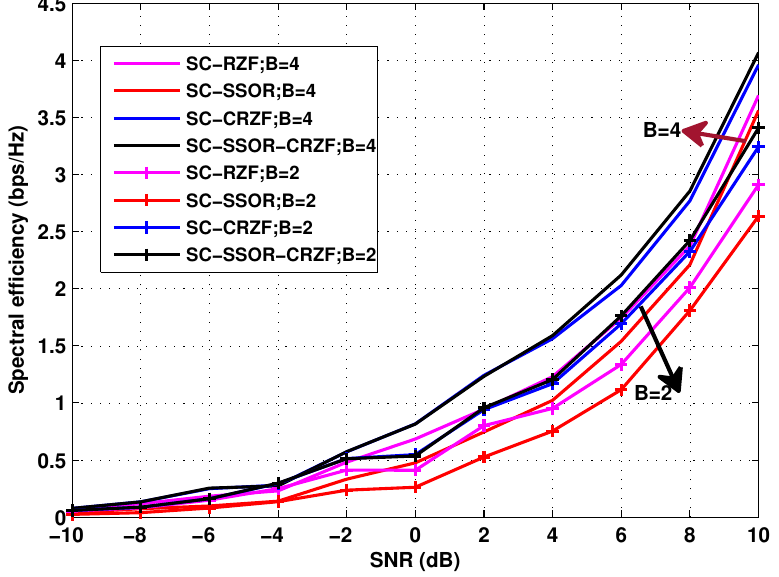
Figure 4. Spectral Efficiency Variation with B